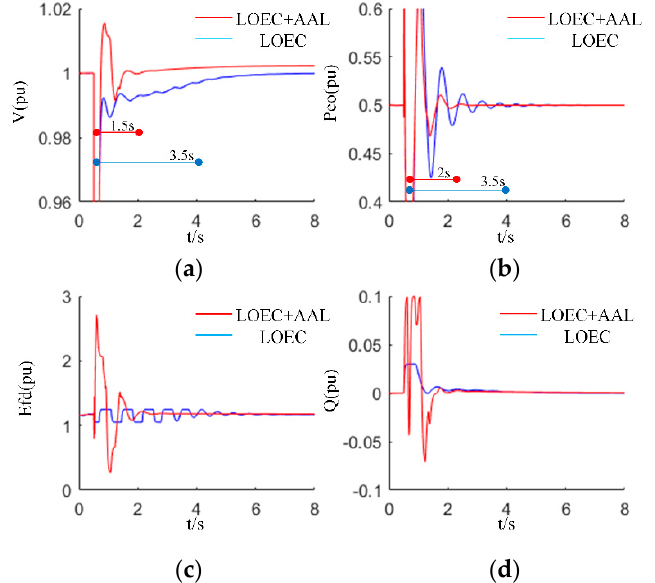
Figure 9. Comparison of coordinated control and traditional control under the single phase proximal fault. ( a ) terminal voltage ( b ) active power ( c ) field voltage ( d ) reactive power injection.